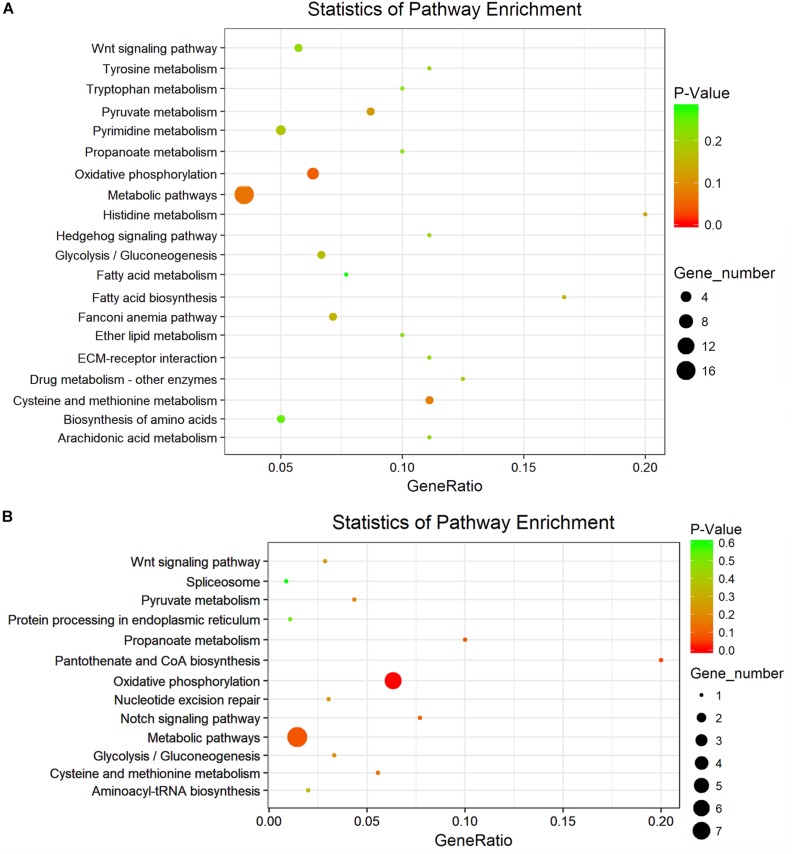
KEGG analysis with the 20 most enriched pathways. The coloring of the P value indicates the significance of the enriched factor. The circle indicates the target genes that are involved, and the size is proportional to the gene number. (A,B) KEGG analyses with the top 20 enriched pathways of the differentially expressed mRNAs in S. japonicum between S_F vs. B_F (A) and between S_M vs. B_M (B).